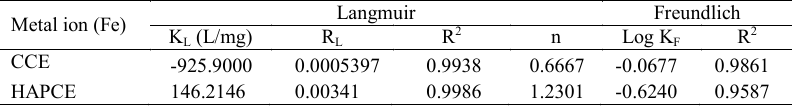
Table 2: Langmuir and Freundlich isotherm models for both bio-sorbents Metal ion